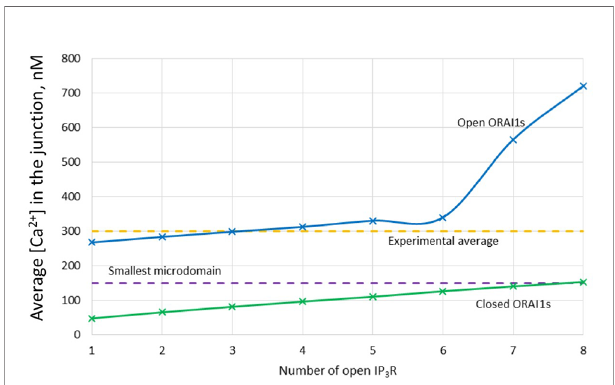
FIGURE 4 | Evolution of the amplitude of the simulated Ca 2+ microdomains with the number of simultaneously open IP 3 Rs in the junction in the presence and in the absence of ORAI1s in the junction. The blue curve (with ORAI1) corresponds to the situation considered in Figure 3 . The theoretical situation of a junction that does not contain ORAI1 channels (green curve) allows to appreciate that the contribution of Ca 2+ released through the IP 3 Rs to the Ca 2+ microdomain is rather